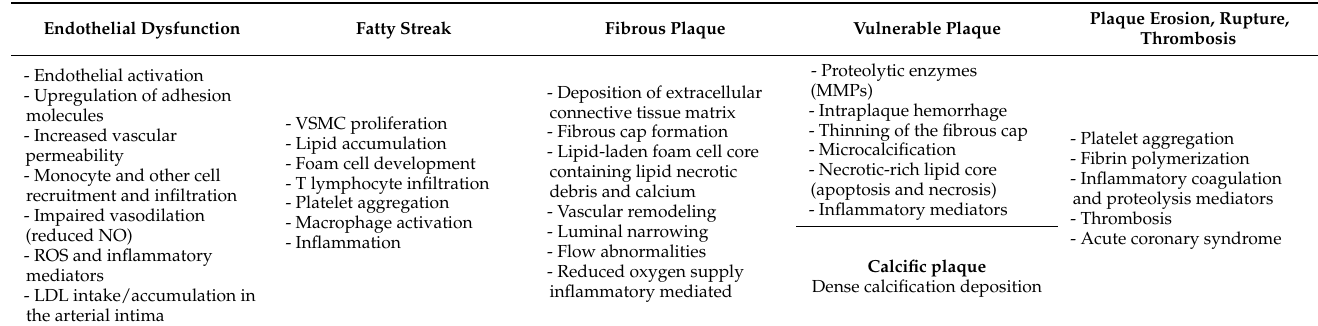
Table 1. Summary of the critical molecules and events characterizing the main phases in the onset and development of the atherosclerotic